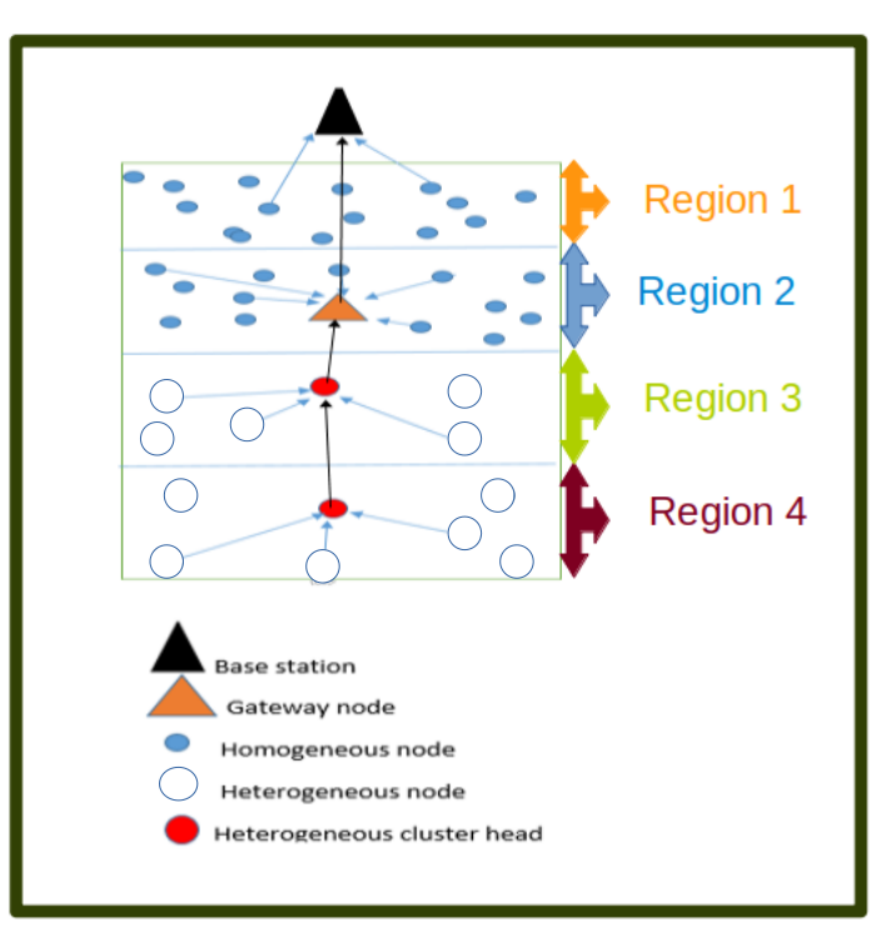
Figure 1. Proposed network